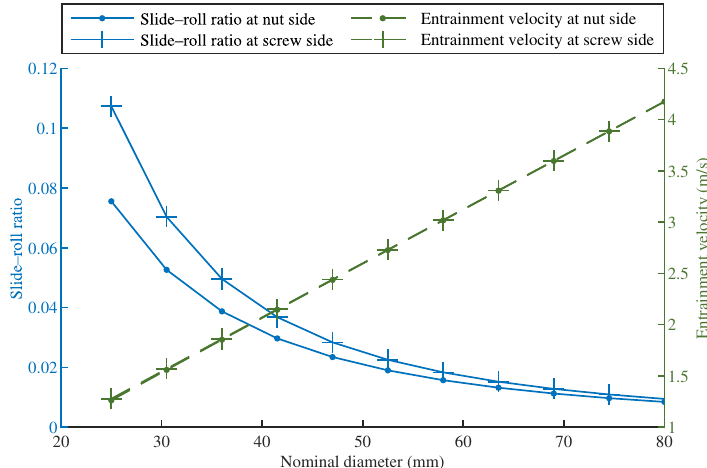
Figure 8. Slide–roll ratio and entrainment velocity under various nominal diameters.